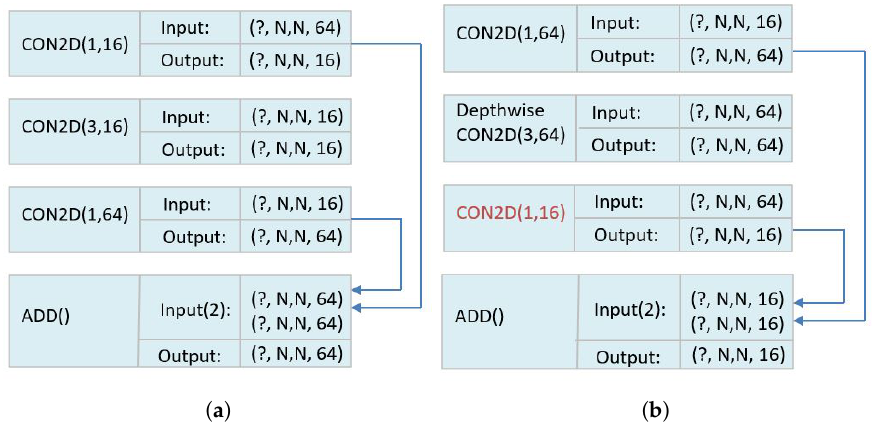
Figure 3. Inverted residual block example; ( a ) regular residual block where channel size changes from 64 → 16 → 64; ( b ) inverted residual block where channels change from 16 → 64 →